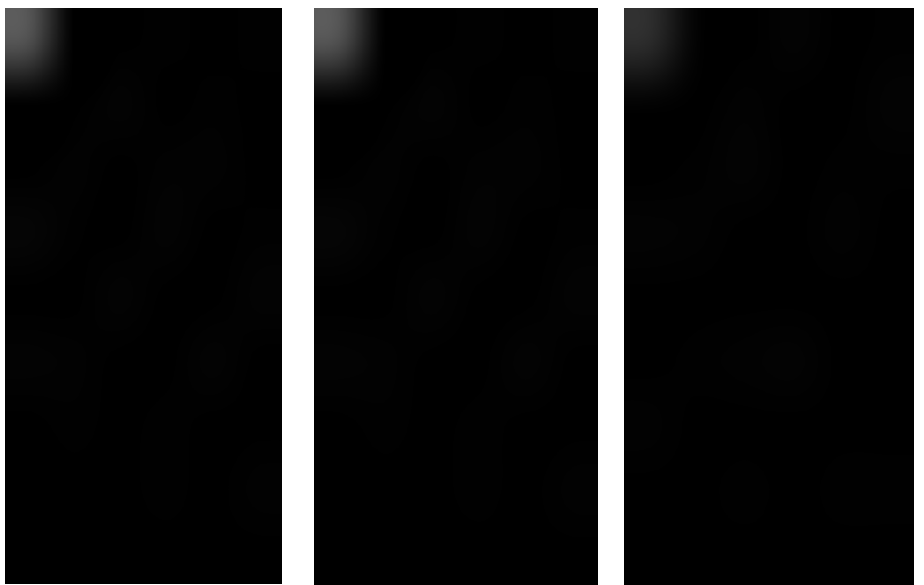
Figure 4. Samples of the converted images from the original clinical